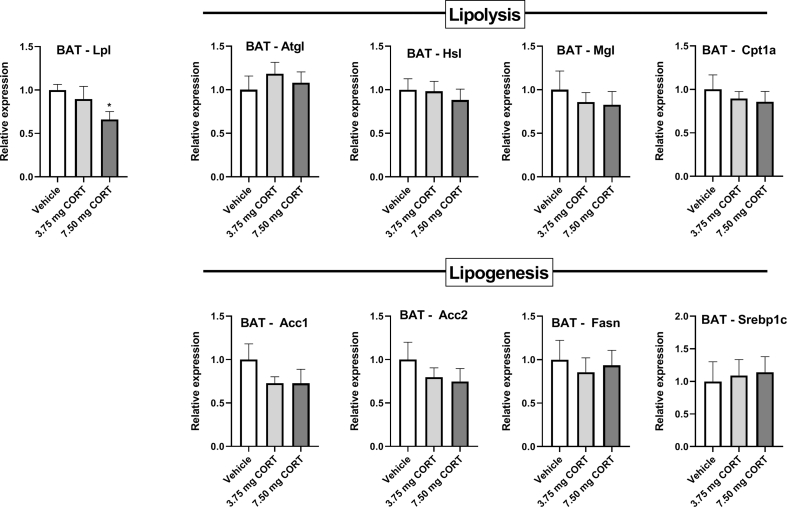
Flattening of corticosterone rhythm decreases Lpl expression in iBAT. mRNA expression of lipoprotein lipase (Lpl) and genes involved in lipolysis and lipogenesis in interscapular brown adipose tissue (iBAT) of female APOE∗3-Leiden.CETP mice implanted with vehicle, 3.75-mg or 7.5-mg corticosterone (CORT) pellets.